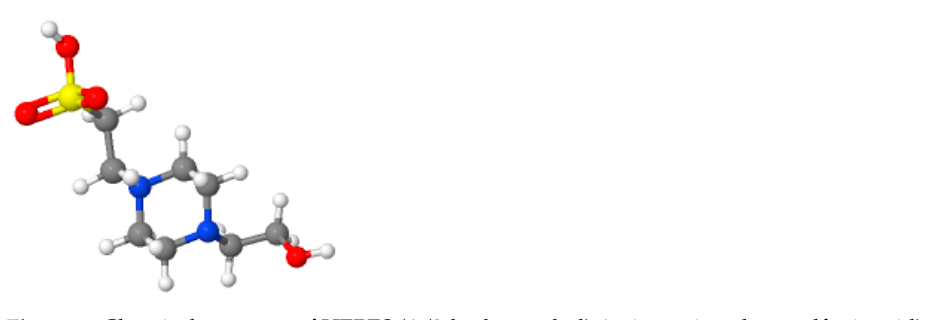
Figure 1. Chemical structure of HEPES (4-(2-hydroxyethyl)-1-piperazineethanesulfonic acid).